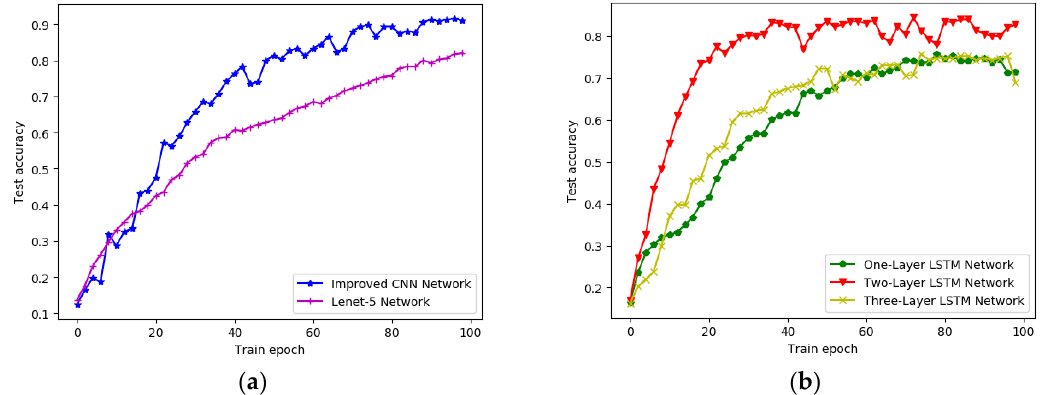
Figure 11. Test accuracy of different networks on field datasets: ( a ) Lenet-5 and improved CNN, ( b ) One-layer, two-layer, and three-layer LSTM network.